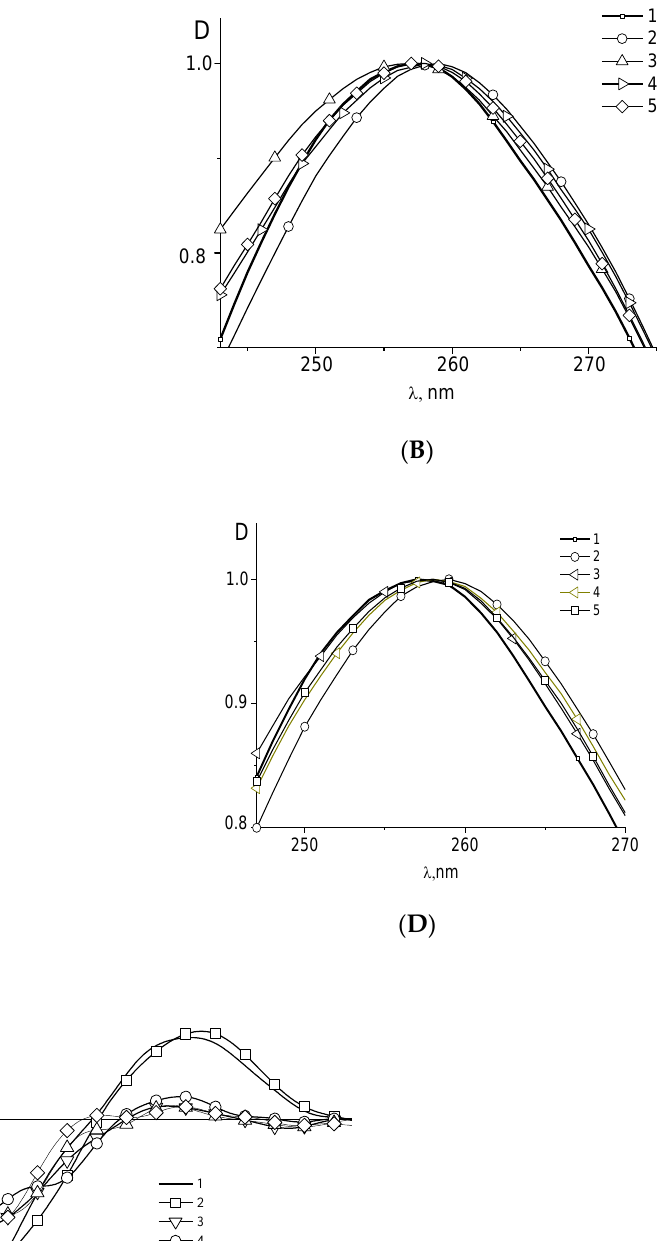
16 of 21 Figure 8. Circular dichroism spectra of DNA in 0.005 M NaCl ( A ) and of DNA complexes in 0.005 M NaCl with cis-DDP at C(cis-DDP) = 2.8 × 10 −6 M ( B ); with Pt4 at C(Pt4) = 6 × 10 −6 M ( C ); with Pt5 in 0.005 M NaCl at C(Pt5) = 5 × 10 −6 M ( D ); with Pt5 in 1 M NaCl at C(Pt5) = 5 × 10 −6 M ( E ), pH values are given near the lines. ; and with Pt3 ( F ) in 0.005 M NaCl at C (Pt3) = 0 (1) 6 × 10 −6 M (2) and 1.07 × 10 −5 M (3) , at pH = 6.2 (a) and 4.2 (b). We also study the competition for the binding site on DNA between several coordi- nation compounds. Figure 9 shows that Pt4 binding prevails over the interaction of cis- DDP with DNA. The binding with N7G occurs for both compounds. It was shown that Pt4 coordinates to DNA via two platinum atoms and induces bending of the double helix. Our results indicate that the binding of Pt4 blocks the formation of bidentate complexes